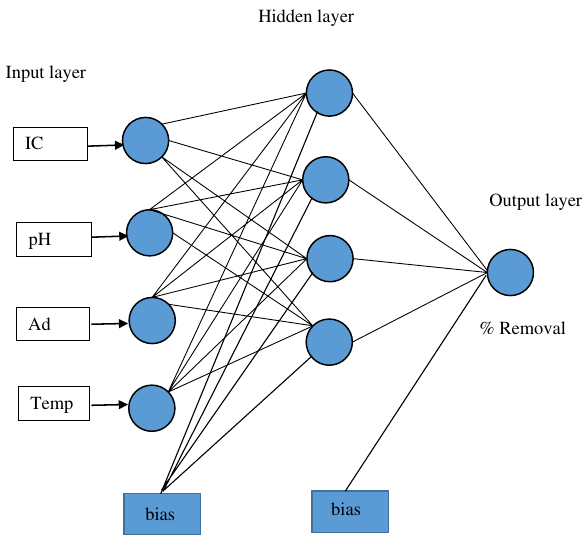
Fig. 1 Network architecture for ANN model